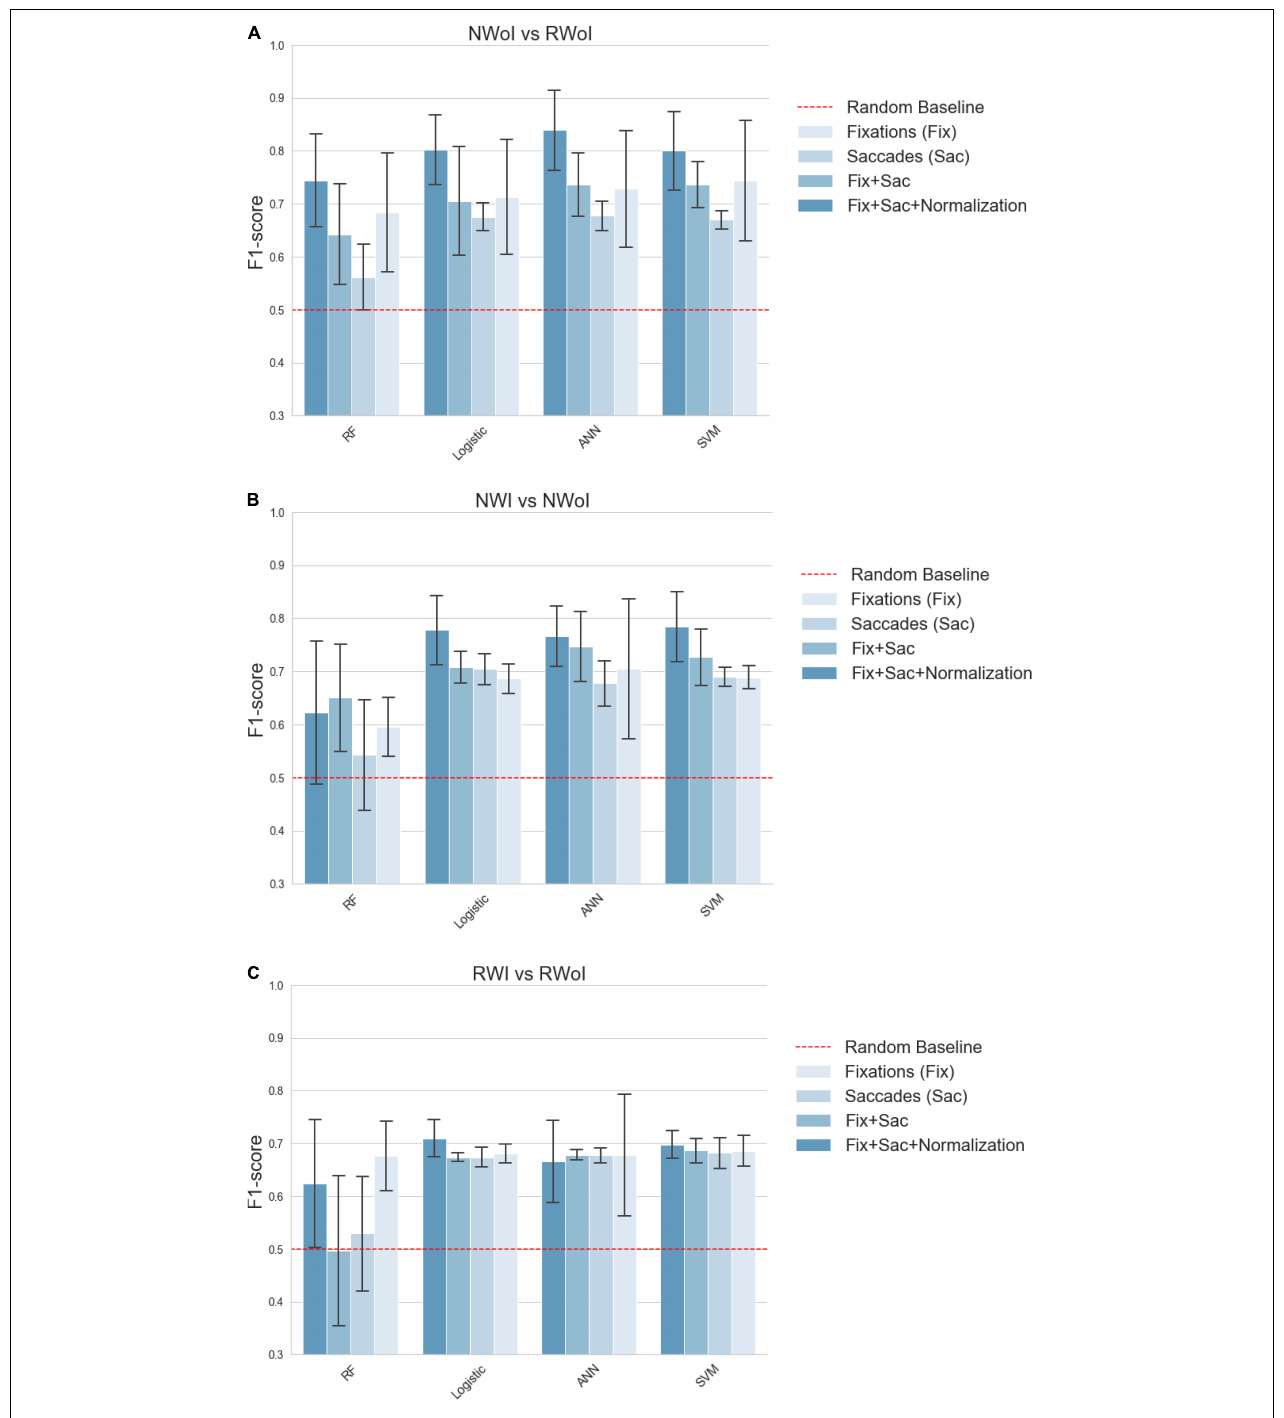
FIGURE 6 | Classification performances in terms of F1-score . (A) Naming without Interference vs Reading with Interference. (B) Reading with Interference vs Reading without Interference. (C) Naming with Interference vs Naming without Interference. Each plot represents a different binary classification task, indicated in the title. Bars indicate the average F1-score on a 5-fold cross validation setting, while the confidence interval represented by black lines on the top of each bar indicates the standard deviation. Each group of contiguous bars refers to the performance achieved by the same classifier: SVM, RF, ANN, and Logistic. Bar’s color indicates the set of features fed as input to the classifier: Fix (features related to fixations), Saccades (features related to saccades), Fix + Saccades (features related to fixations and saccades), Fix + Saccades-norm (features related to fixations and saccades with subject-wise normalization). The dashed red line sets the reference of the random baseline.For both parameters (Accuracy and F1 -score) all the classifiers and features pairs are significantly above the random baseline 0.5, and in best cases above 0.8, with a similar but not identical pattern of results between Accuracy and F1-score.